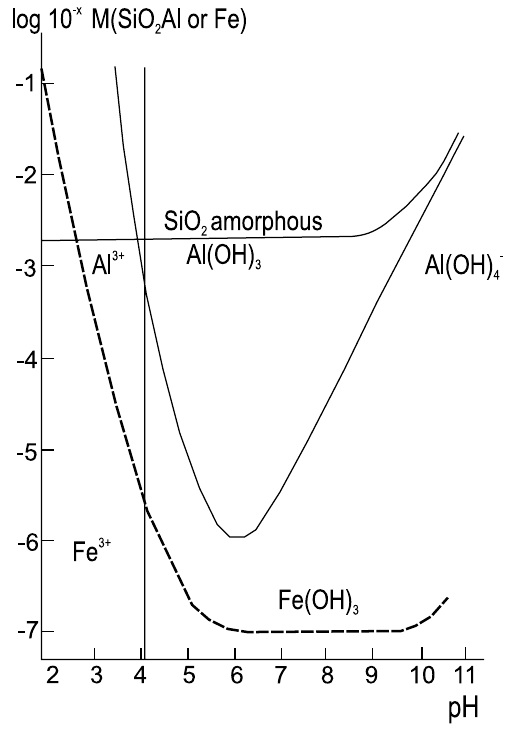
Fig. 6 – The solubility of aluminum hydroxide, amorphous silica and ferric oxide in terms of ph in superficial